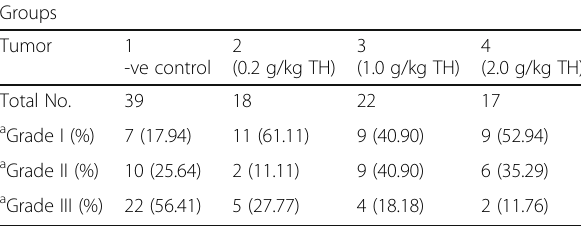
Table 3 Histological grading b of tumors in various groups Groups Tumor